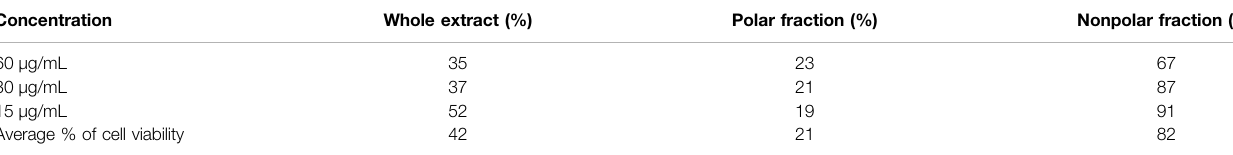
TABLE 7 | Average ofthe percent viability of murine lymphoma L5178Y cells treated with the ethanolic extract and polar and nonpolar fractions of Lophocereus schottii (µg/ mL). p < 1.7X10-15. Concentration Whole extract (%)